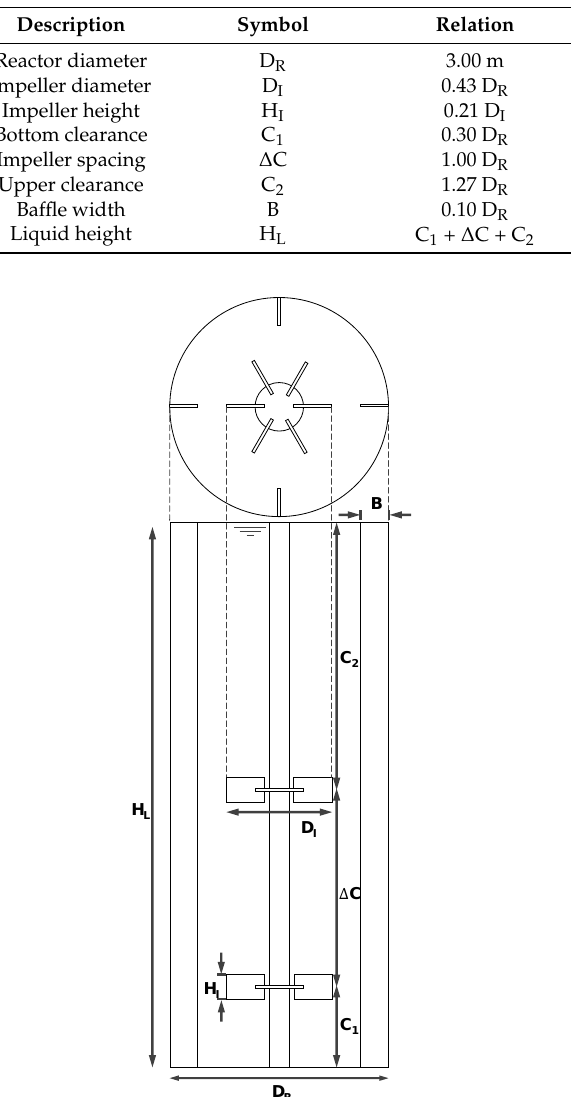
Table A1. Dimensions of the reactor setup pictured in Figure A1.